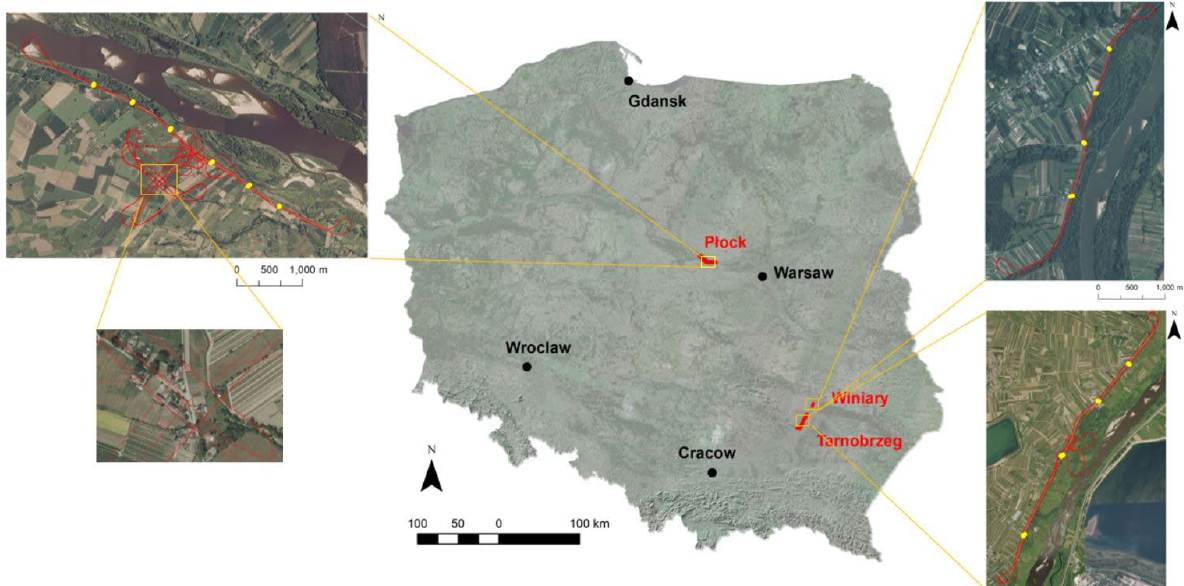
Figure 2. Test sides in the experiment (in red): visualisation of trajectory and control points overlaying the orthophotomap presenting the topography of the test